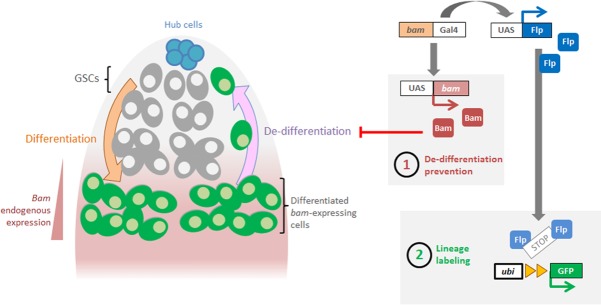
Methodology used for blocking and labeling bam-lineage dedifferentiation.GSCs undergo four rounds of mitotic divisions, and the 4- to 8-cell spermatogonia activate the bam-Gal4 driver. This Gal4 drives expression of UAS-bam, resulting in the production of more Bam differentiation factor in these cells. This ectopic Bam prevents dedifferentiation (‘1’). For controls, UAS-bam is replaced by a UAS-LacZ. Concomitantly, bam-Gal4 also drives the expression of Flippase (Flp), which then recombines irreversibly the ubiP63E-FRT-stop-FRT-GFP cassette (‘2’). This indelibly labels with GFP bam-lineage cells and allows the tracking of bam-lineage dedifferentiated GSCs.